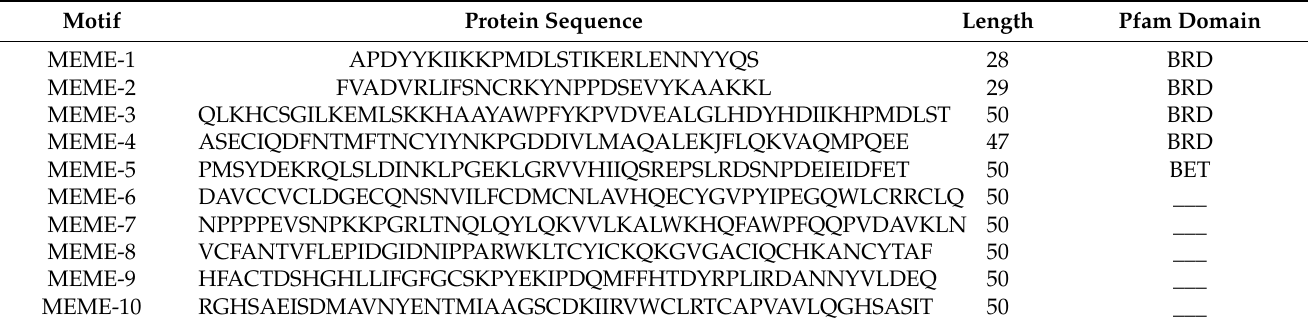
Table 1. Ten distinct motifs generally detected in buffalo BRD family.